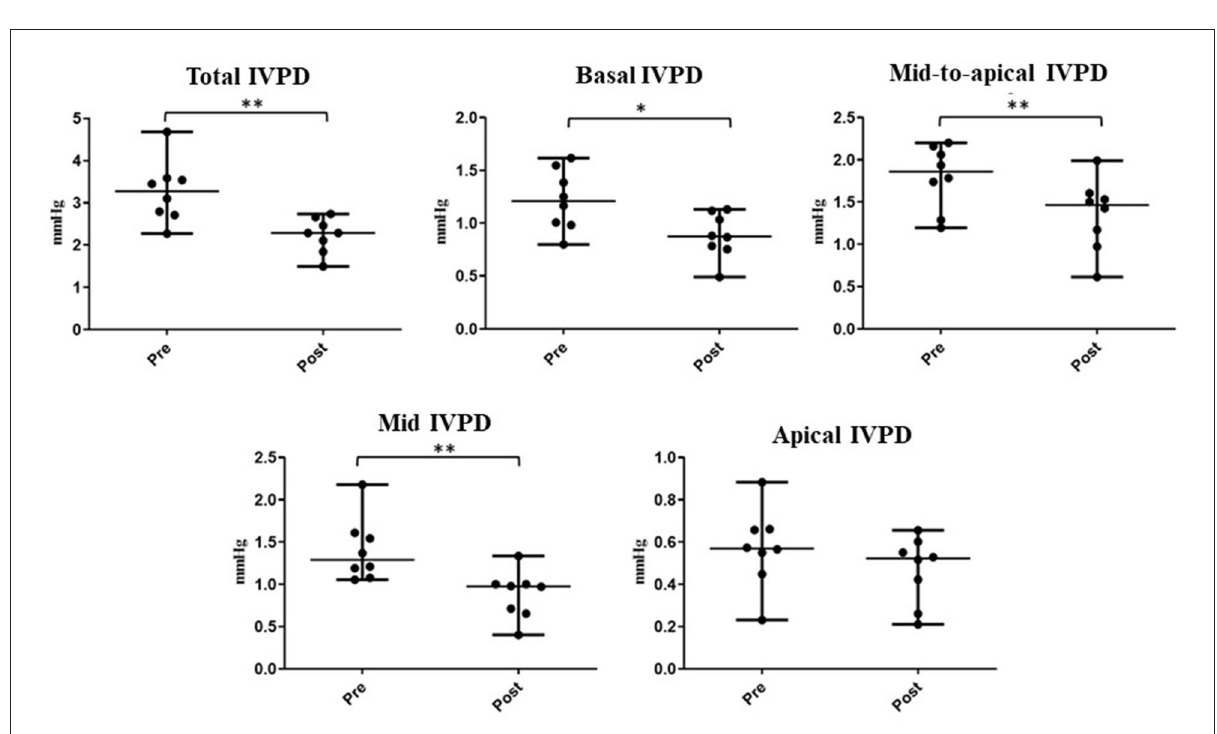
FIGURE4 Changes in IVPD indices measured by color M-mode echocardiography before and after sedation with xylazine in goats ( n = 8). Plots showing the median (central horizontal line) and range (upper and lower lines). * p < 0.05, ** p < 0.01.